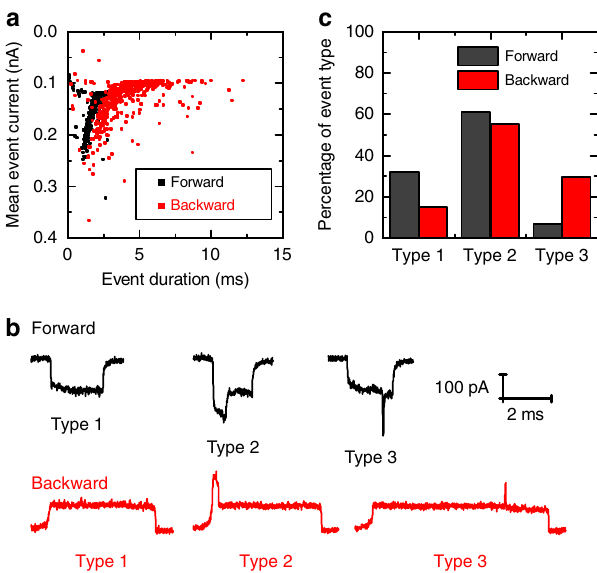
Fig. 2 Comparison of scatter plot and translocation types observed for forward and backward directions. a Scatter plot showing statistics of forward and backward translocations for 8 kbp DNA recorded in ping-pong experiments using 570 events. b Typical examples of events categorised into three types: Type 1 showing only one level, Type 2 showing a fold at the event beginning and Type 3 showing no beginning fold but a later deviation. c Relative frequency of occurence of the three event types in forward and backward translocations